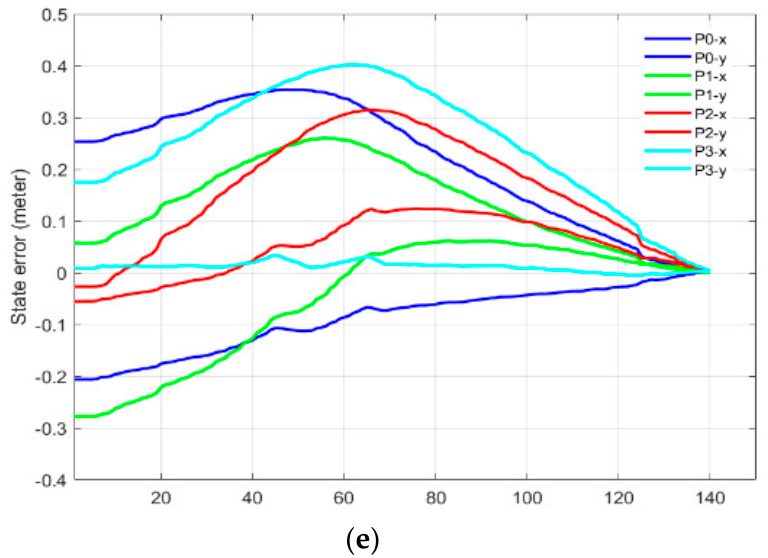
Figure 12. Mix frame visual servo control near the base frame ( a ) starting pose external camera, ( b ) eye-in-hand camera view; initial and desired image features encompassing self-collision, ( c ) feature trajectory in the image plane, ( d ) mix frame end-effector velocity, and ( e ) visual feature error decay in the mixed-frame.